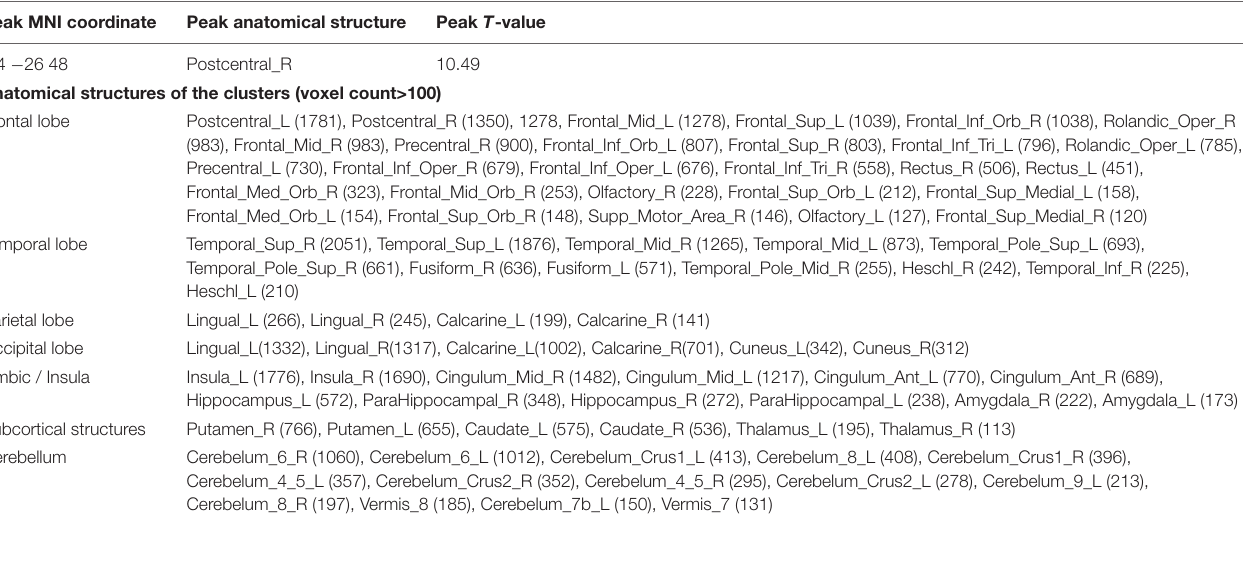
TABLE 4 | Anatomical structures correlated with age in